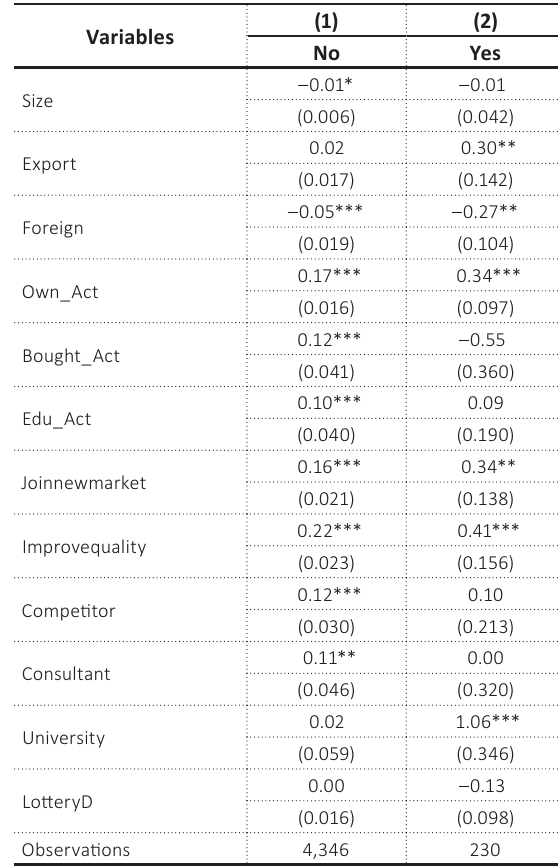
Table 3. Moderating effects of